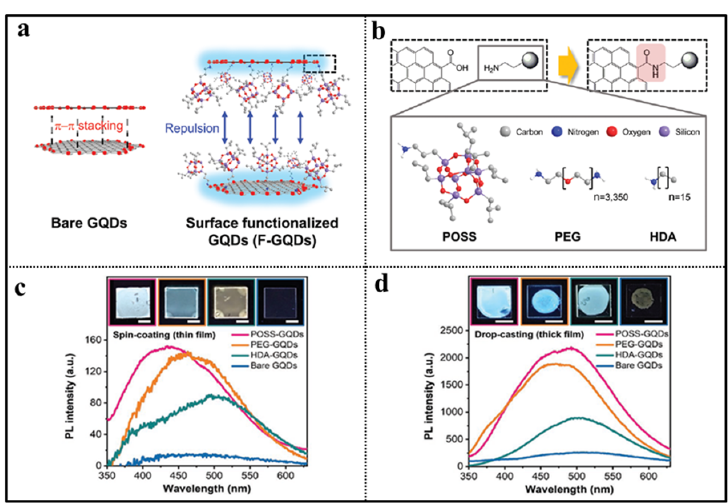
Figure 8. ( a ) Synthetic procedure of POSS-CdSeTe QDs [81]. ( b ) The PL spectra and cytotoxicity of SiHa cells incubated with different concentrations of POSS-CdSeTe QDs and CdSeTe QDs [81]. Graphene quantum dots (GQDs) [82], as nanometer-sized graphene derivatives with low toxicity, low-cost processing, and unique PL properties, provide new possibility to replace the aforementioned QDs due to their high PL stability. However, the strong π – π stacking interactions induce the aggregation-caused PL quenching (ACQ) in the solid state, which greatly limits their application. Recently, Jeon and co-workers demonstrated for the first time that surface functionalization of QDs (F-GQDs) by POSS, poly(ethylene glycol) (PEG), and hexadecylamine (HDA) could effectively reduce ACQ (Figure 9) [83]. The surface functionalization was achieved by the carbodiimide coupling chemistry between the primary amine of POSS, PEG, and HDA with the carboxyl groups on the edge of the GQDs. In solutions, the photophysical properties of F-GQDs were similar to those of bare GQDs with the absorption peak at less than 300 nm and PL peak at about 400 nm. While the POSS-GQDs, PEG-GQDs, and HDA-GQDs showed a significant enhancement in PL intensity compared to bare GQDs by 9.5-, 9.0-, and 5.6-fold in spin-coated film form and by 8.3-, 7.2-, and 3.4-fold in drop-casted film form, respectively. The results indicated that the POSS was an excellent functionalizing reagent for GQDs.